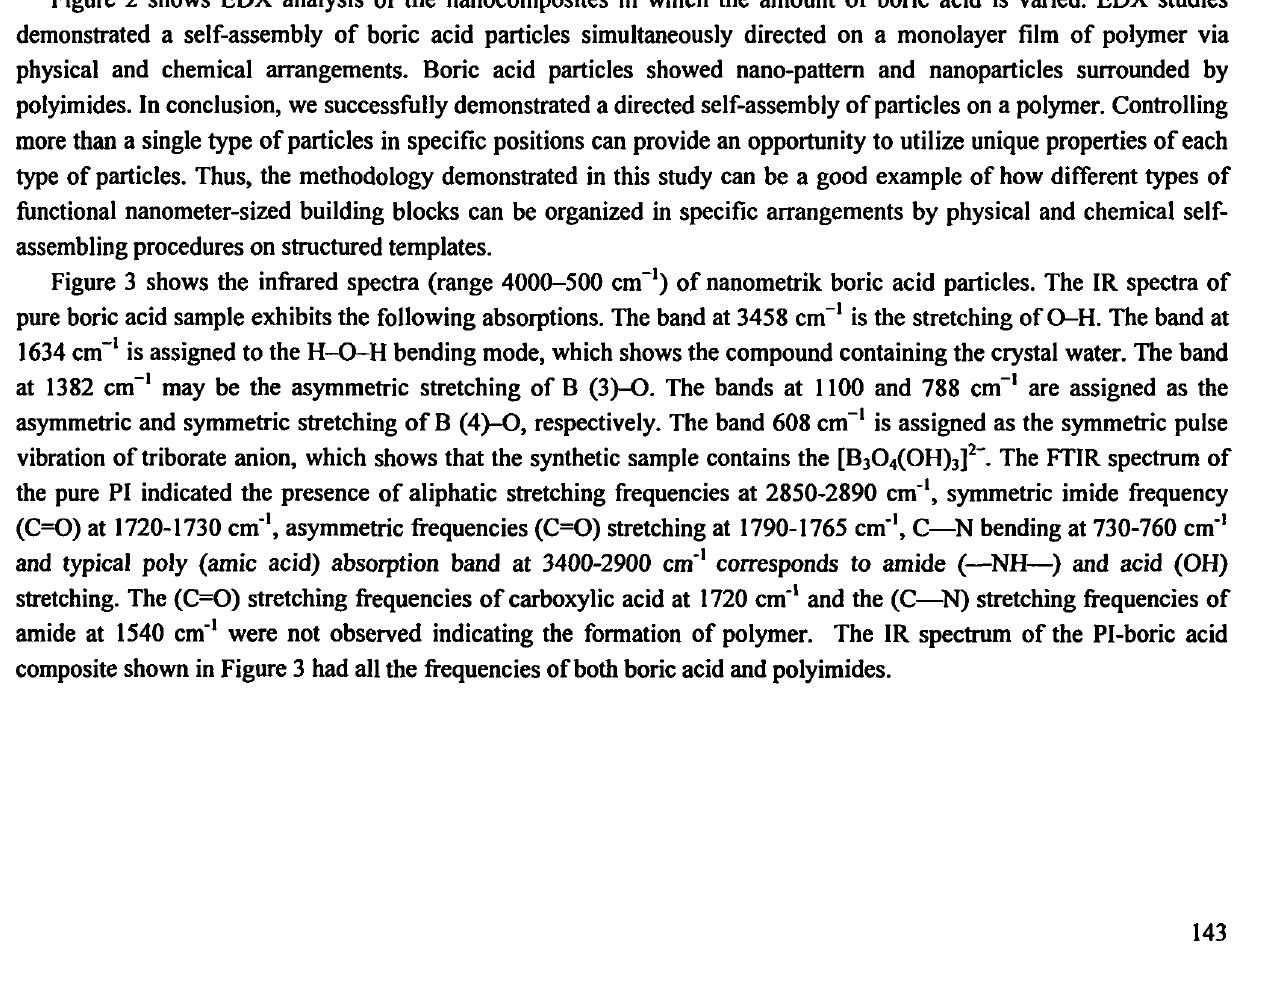
Fig. 1: XRD of boric acid powders (a) and Pi/boric acid nanocomposites